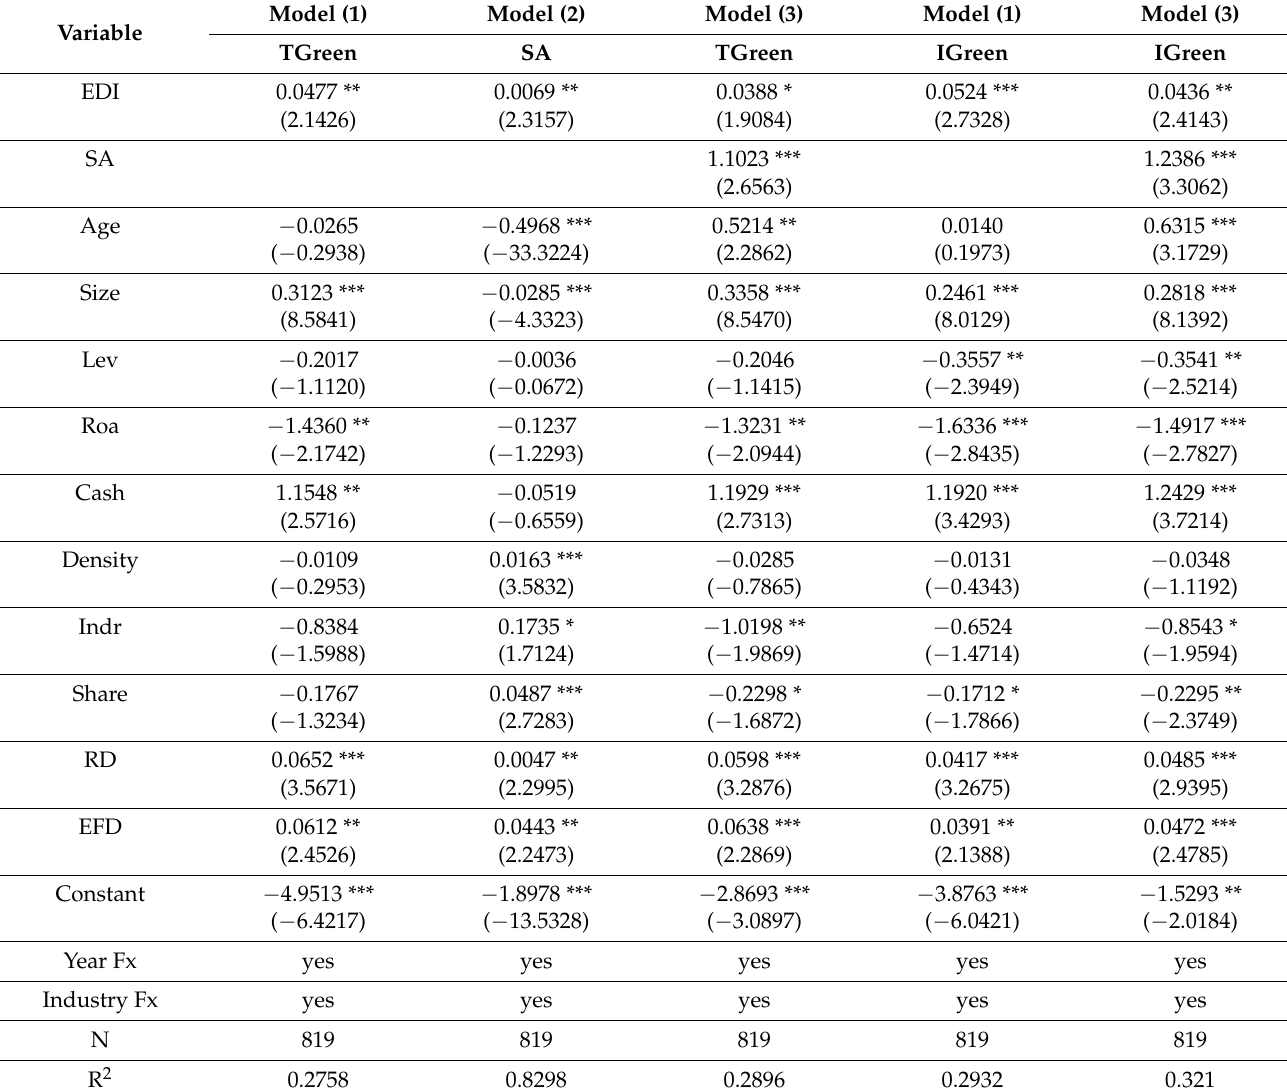
Table 5. Mediating effects of financing